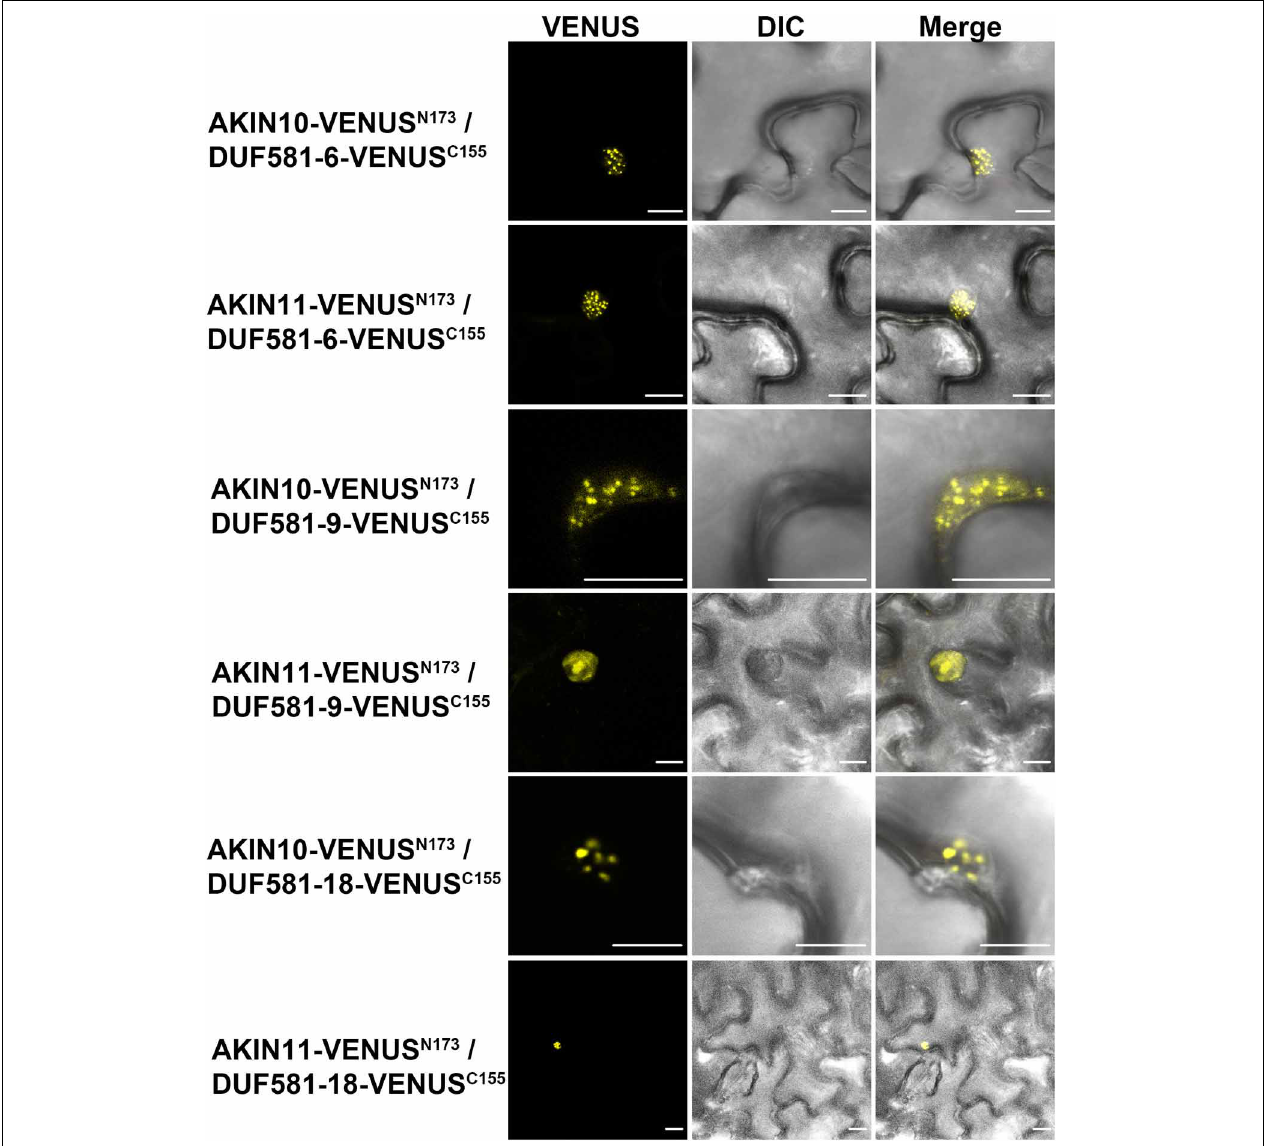
FIGURE 7 | AKIN10/11 interact with DUF581 proteins in sub-nuclear foci. Visualization of protein-protein interactions in planta by the BiFC assay. Venus confocal microscopy images show N. benthamiana leaf epidermal cells transiently expressing constructs encoding the fusion proteins indicated. Bars = 10 μ